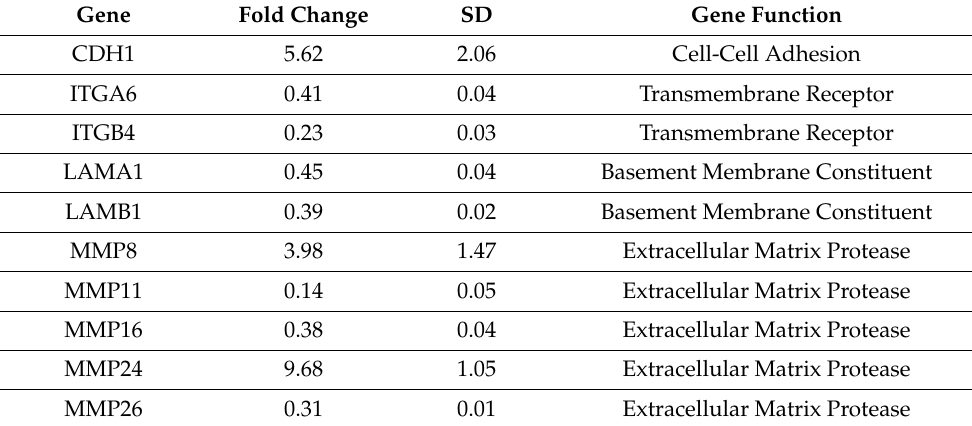
Table 2. Significant gene expression levels after 24 h treatment with nifedipine, as compared with untreated cells ( n =